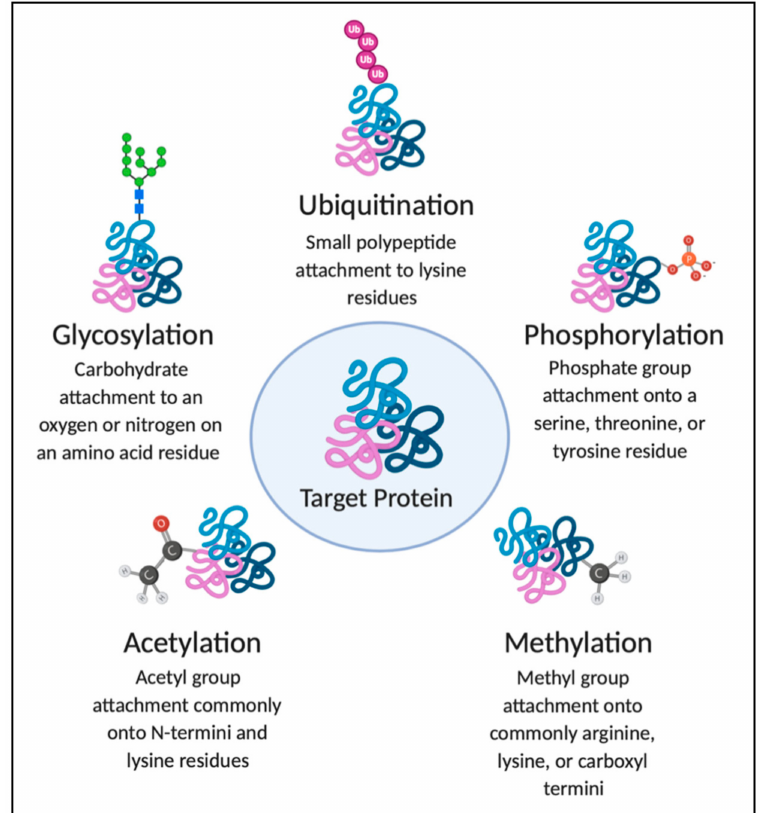
Figure 1. Post-translational modifications highlighted in this review. Fungal proteins can be modified following translation to derive a wide array of unique functions. These diverse modifications may involve covalent or noncovalent additions of polypeptides or proteins, complex molecules, chemical groups, as well as proteolysis. The primary PTMs discussed in this review include phosphorylation, acetylation, deacetylation, ubiquitination, and